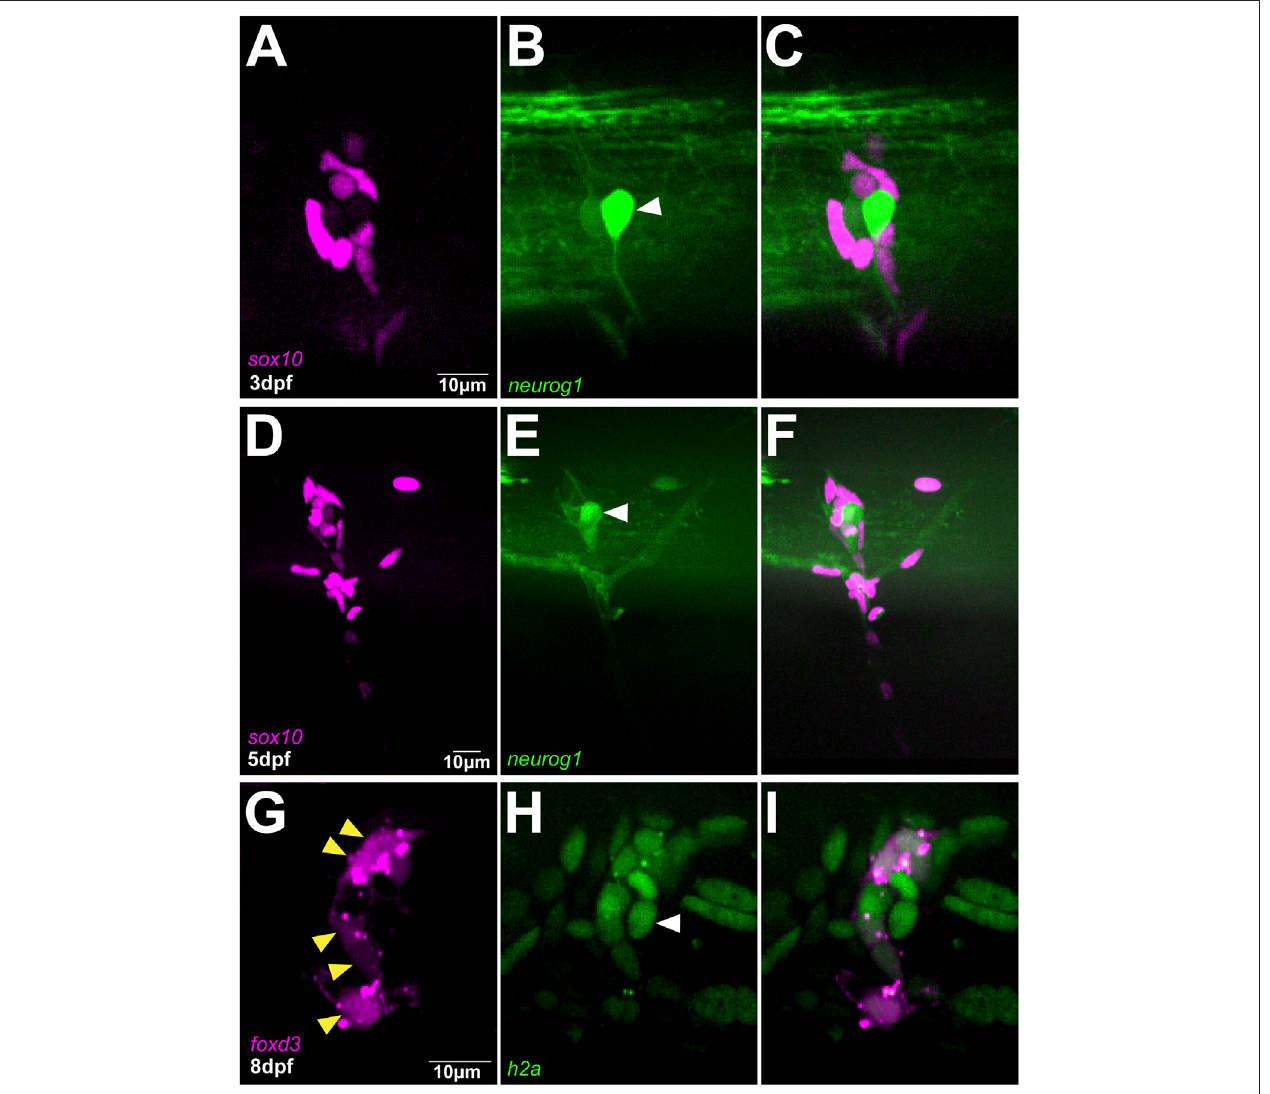
FIGURE3| DRGisexclusivelyformedbyfollowers (A – C) ConfocalimagesofSox10:mG;neurogenin1:GFPat3dpfshowingthedifferentiationofafollowercellinto the primary neuronof DRG indicated bywhitearrowhead (D – F) ConfocalimagesofinSox10:mG; neurogenin1:GFP embryoat 5dpfshowing amore mature DRG (G – I) ConfocalimagesofFoxD3:mCherry;H2aFVA:H2A-GFPembryoat8dpfshowingtheperipheralfollowersexpressingFoxD3,yellowarrowheads,andtheprimaryneuron marked by the absence of FoxD3 expression, white